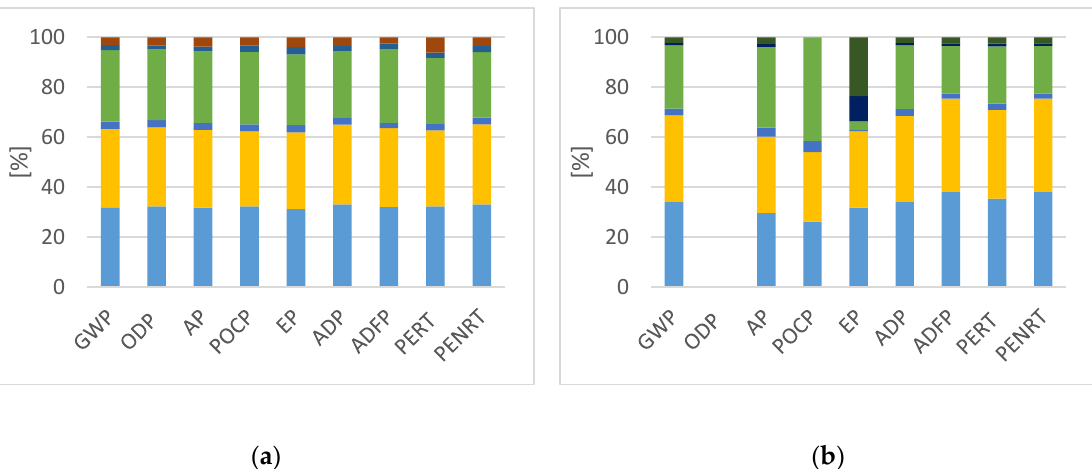
Figure 3. Environmental impact of complete ETICS system with 10 cm thick EPS thermal insulation produced in the year ( a ) 2012, and ( b ) 2017. The data represent the sum of environmental impact from the A3 stage of the ETIC life cycle. Finishing coats represent mean value obtained from the analysis of different renderings, e.g., mineral renders, acrylic render, silicone render and silicone-silicate render. Legend: ( ■ ) adhesive for bonding insulation, ( ■ ) glass fiber mesh, ( ■ ) adhesives for base coats, ( ■ ) key coats, ( ■ ) finishing coats, ( ■ ) primers, and ( ■ ) decorative coats.